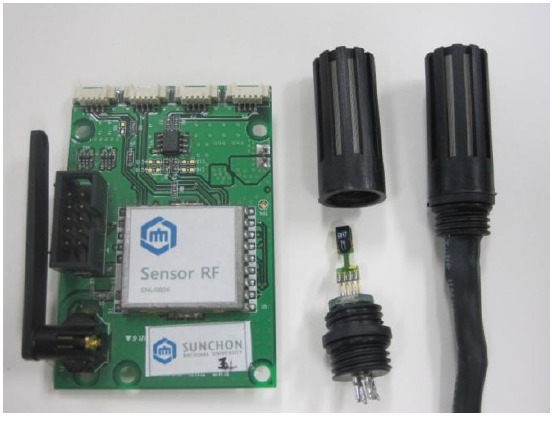
Figure 8. Environmental